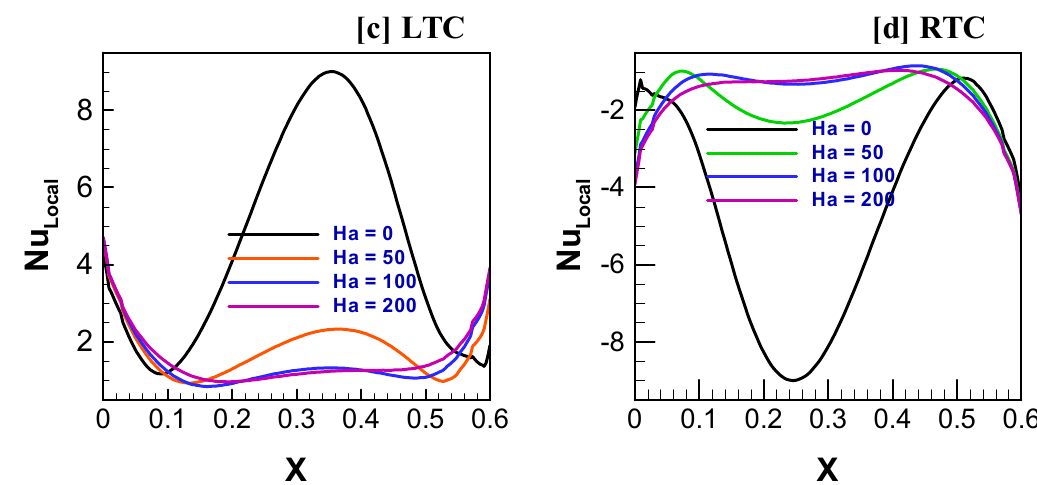
Figure 11. Variations of local Nusselt number with distance for different orientations of heated cylinders for Ha = 0–200, Ra = 10 5 and Pr = 0.71.